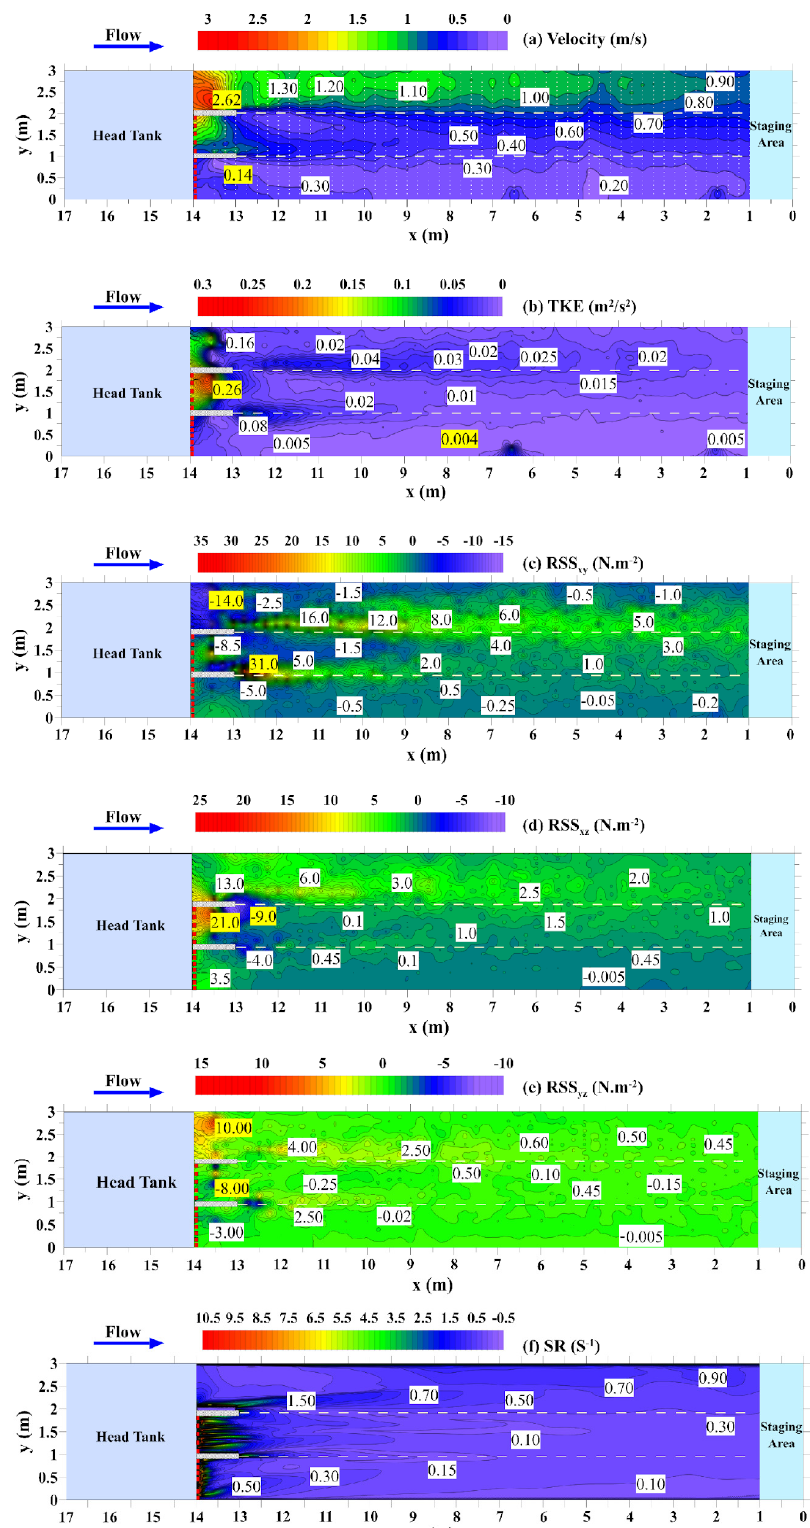
Figure 2. Contour plots of flume hydraulics and tolerances: ( a ) flow velocity (m/s), with the white dots indicating ADV measurement points, the white dashed lines indicating the flow regime boundaries, and the yellow labels in each contour plot indicating the minimum and maximum values of hydraulic factor, ( b ) TKE (m 2 /s 2 ), ( c ) RSS xy (N · m − 2 ), ( d ) RSS xz (N · m − 2 ), ( e ) RSS yz (N · m − 2 ), and ( f ) SR (s − 1 ).